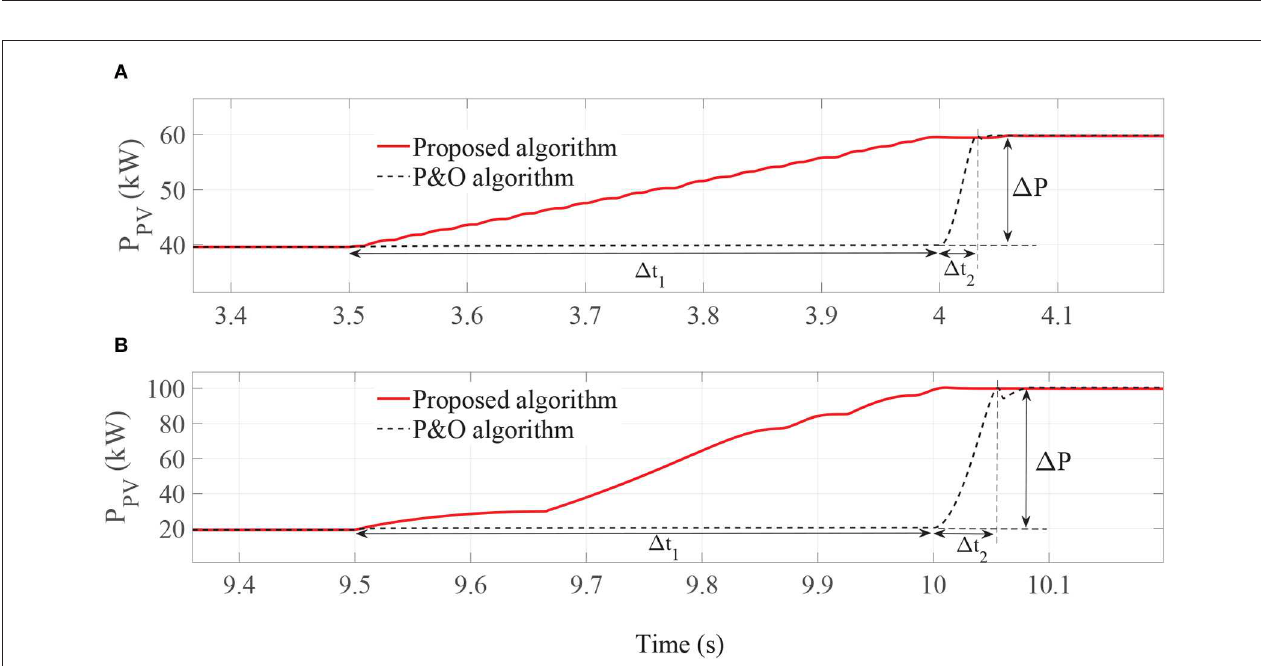
FIGURE 10 | PV output power responses when solar irradiation increase rapidly. (A) from 400W/m 2 to 600W/m 2 . (B) from 200W/m 2 to 1000W/m 2 .